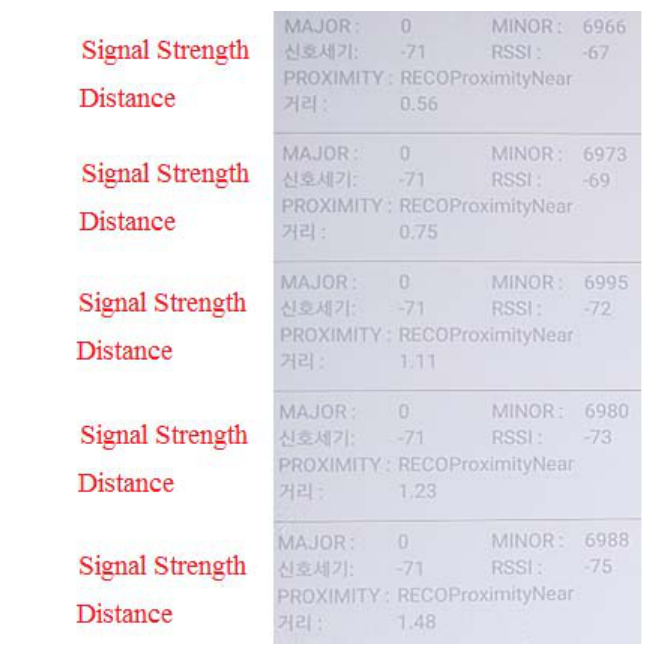
Figure 23. Process of Tracking each Location of the Beacon.